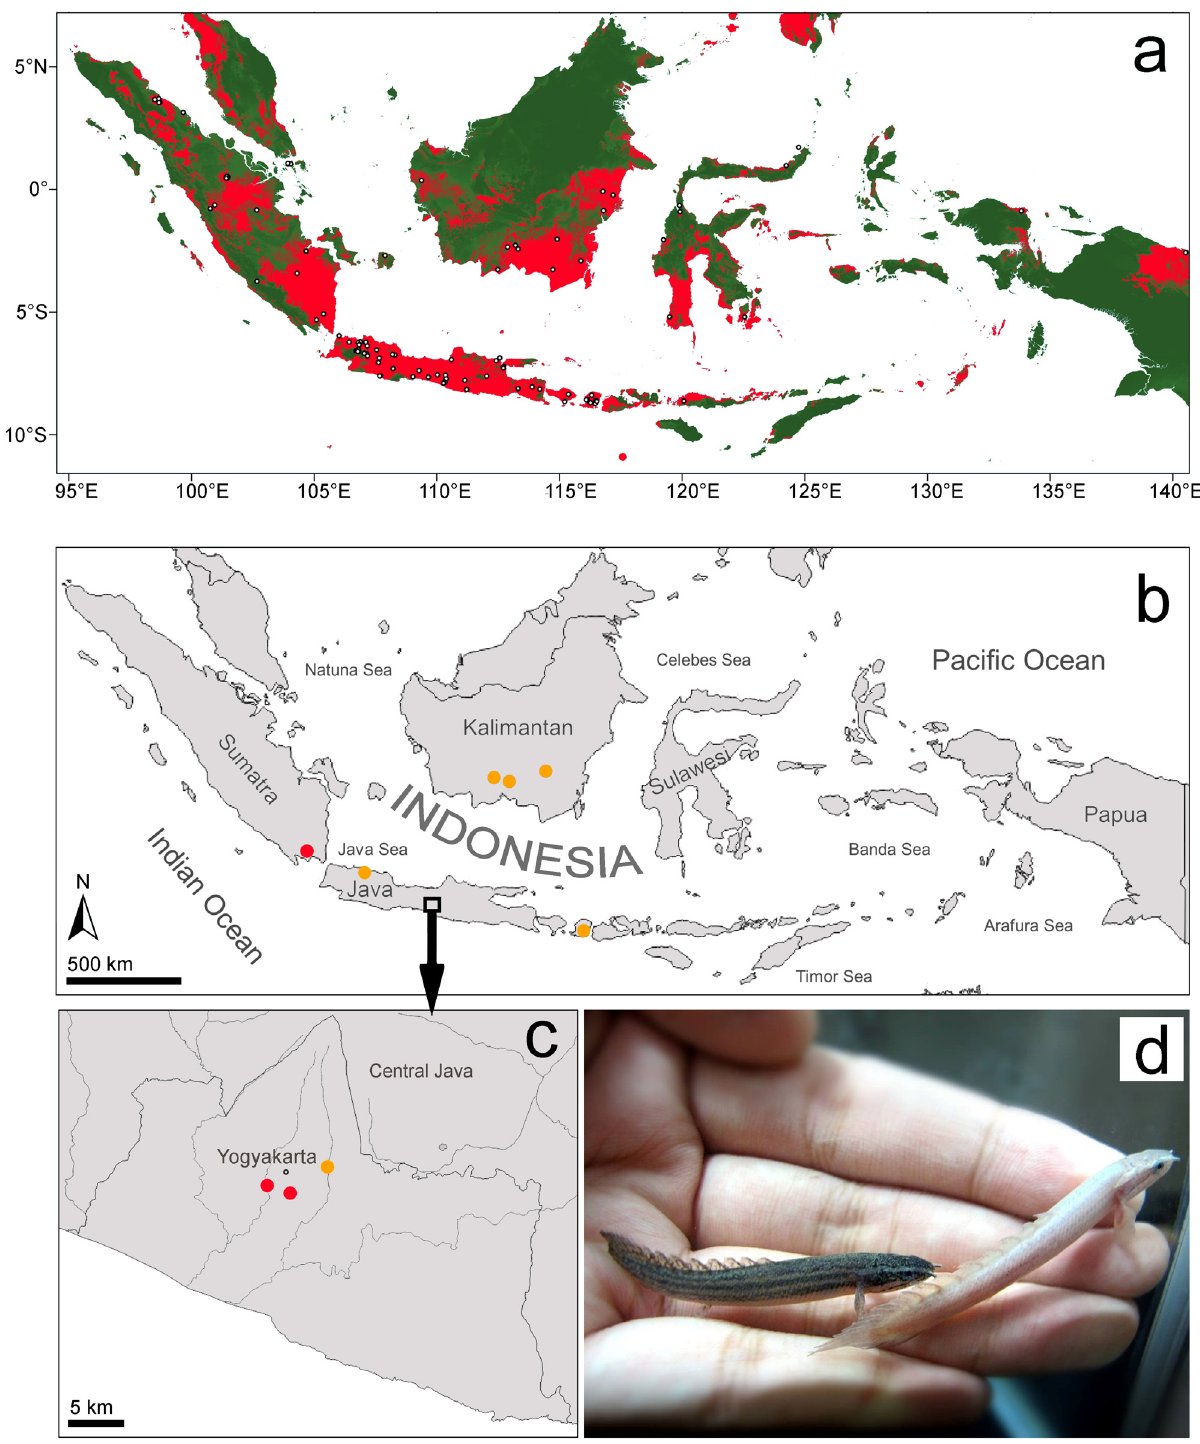
Fig. 2. (a) Map derived from the MaxEnt model for the possible establishment of Polypterus senegalus in Indonesia. Red: areas suitable for establishment; white dots: locations used for model training. (b,c) Red dots: first potentially established population in Indonesia; orange dots: unconfirmed populations. (d) Wild and albino phenotypes captured in the same locality in the Gedong Tataan River